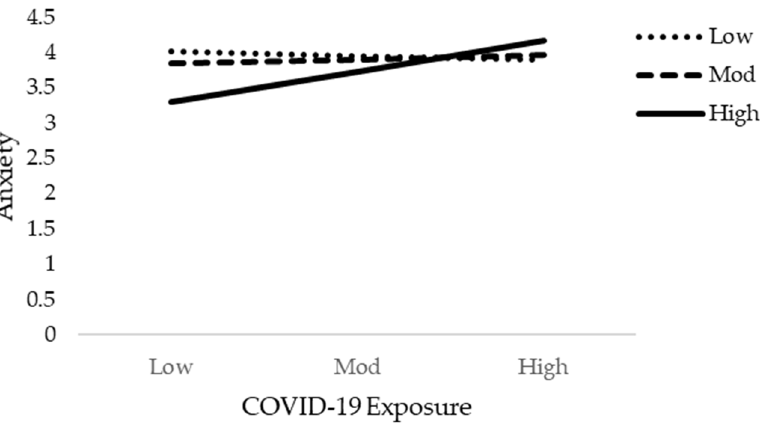
Figure 7. Interactive effect of COVID-19 Exposure and social support on psychological distress.